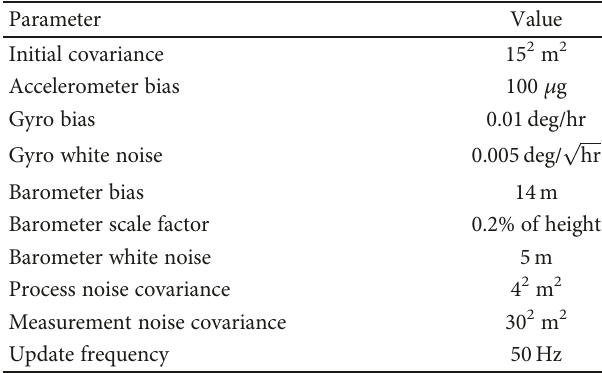
Table 2: Simulation conditions and BKF design